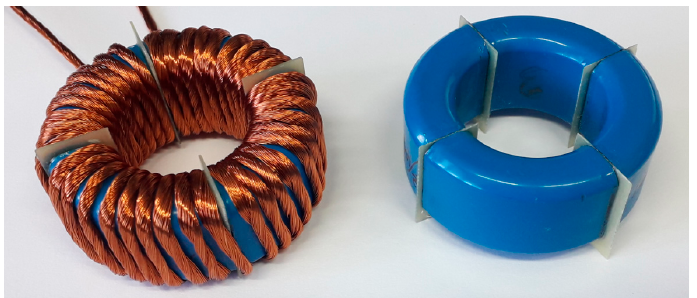
Figure 4. Ferrite toroidal inductor with distributed airgap optimized for high-frequency evaluation of selected transistor structures within considered PFC circuit. Table 3. Design parameters of the PFC inductors for high-frequency operation.